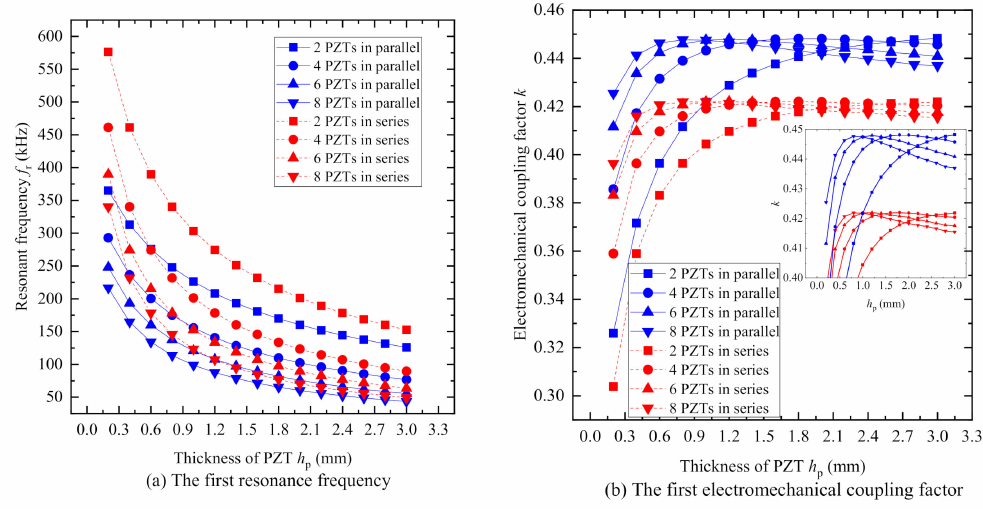
Figure 7. The first resonance frequency f r and electromechanical factor k of PiSSAs versus the thickness of PZT wafer: ( a ) the first resonance frequency; and ( b ) the first electromechanical coupling